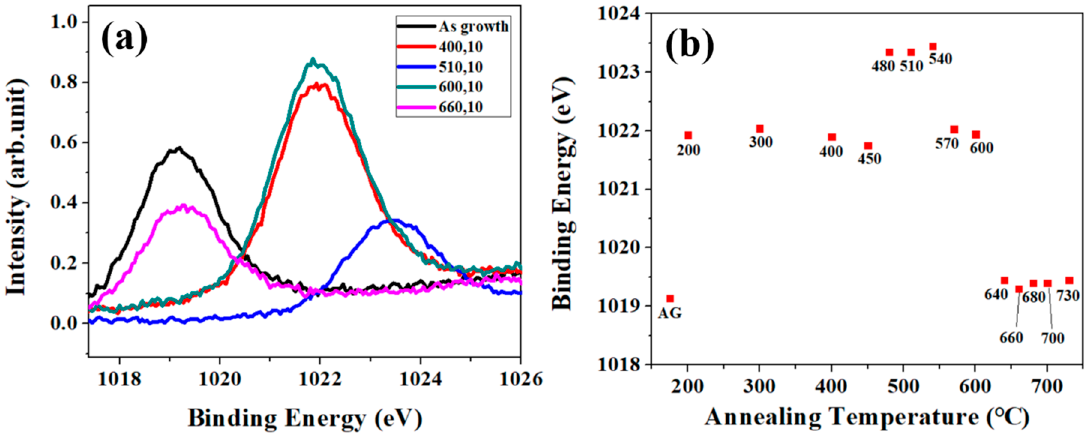
Figure 4. ( a ) Zn2p XPS for SA-ZNRs and ZNRs annealed at varied temperature. ( b ) The peak shift of Zn2p in XPS.